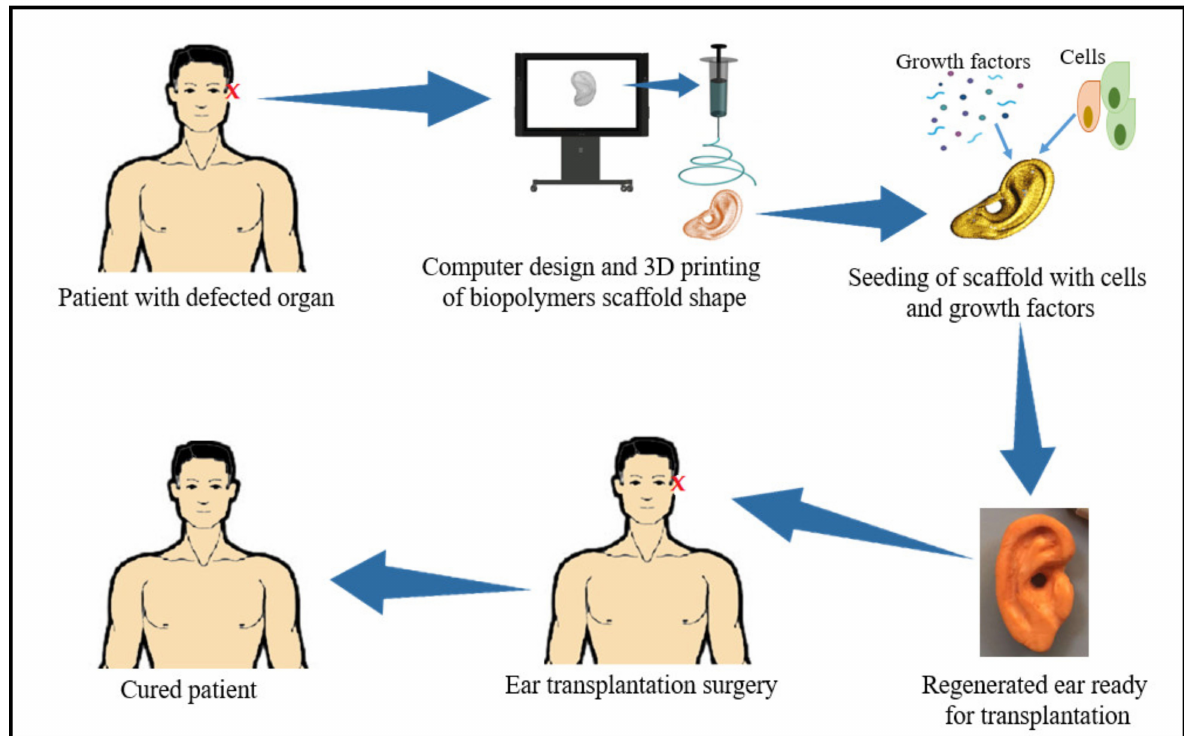
Figure 2. Schematic illustration of the tissue engineering